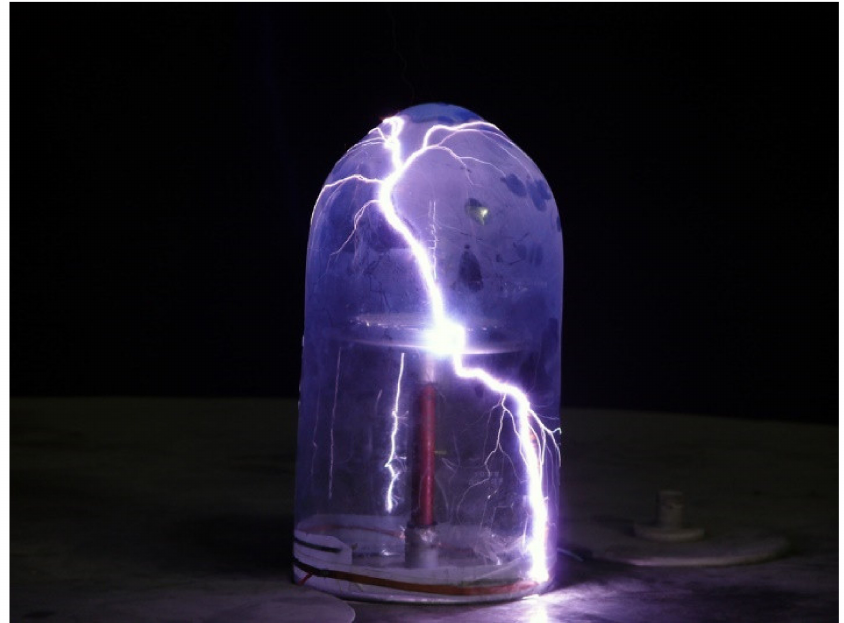
Figure 5. Discharge formation in model radome without lightning